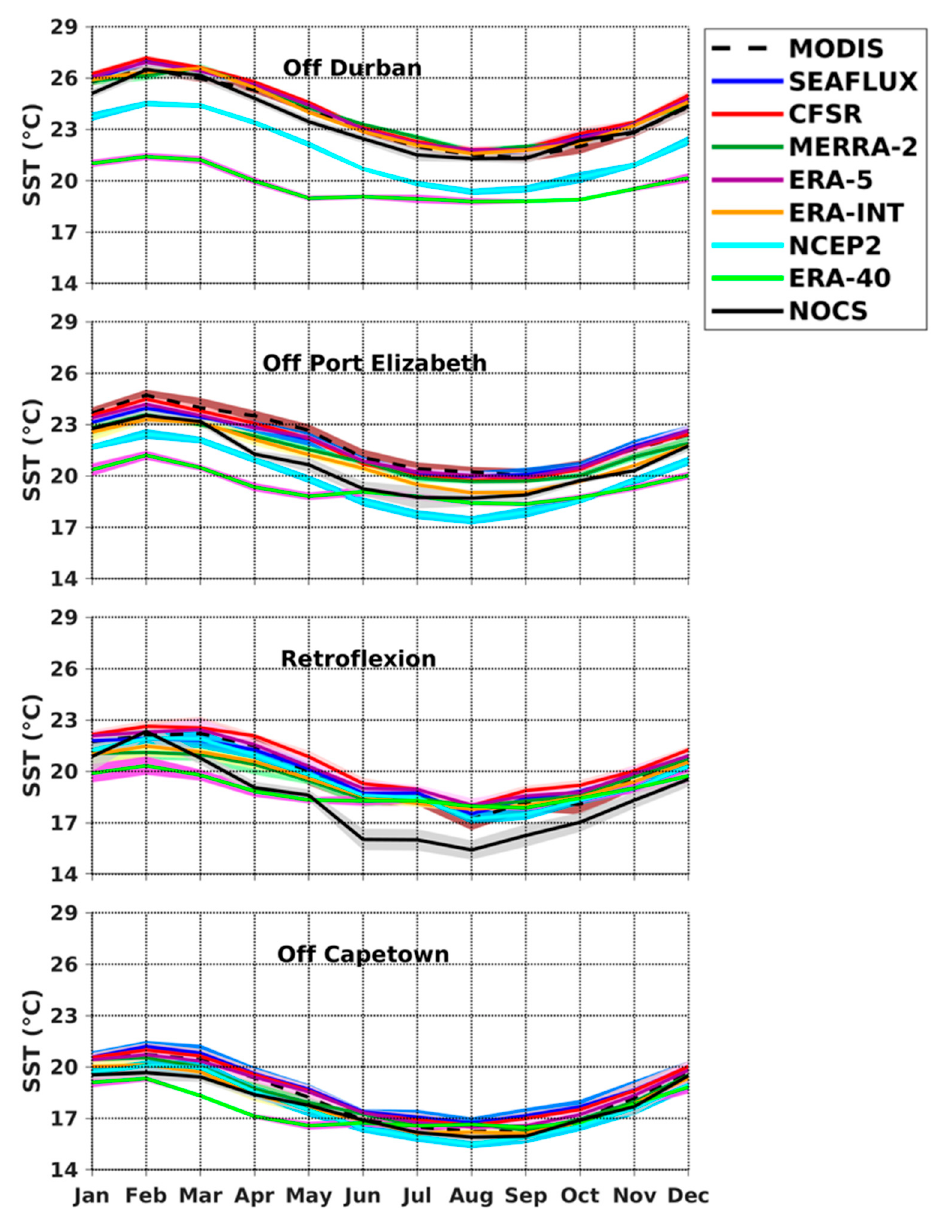
Figure 6. Annual cycles of sea surface temperature ( ◦ C) o ff Durban, o ff Port Elizabeth, Retroflection and o ff Cape Town for MODIS (black dash), SEAFLUX (blue), CFSR (red), MERRA-2 (green), ERA-5 (purple), ERA-Interim (yellow), NCEP2 (cyan), ERA-40 (purple) and NOCS (black), with their respective envelopes as in Figure 3.